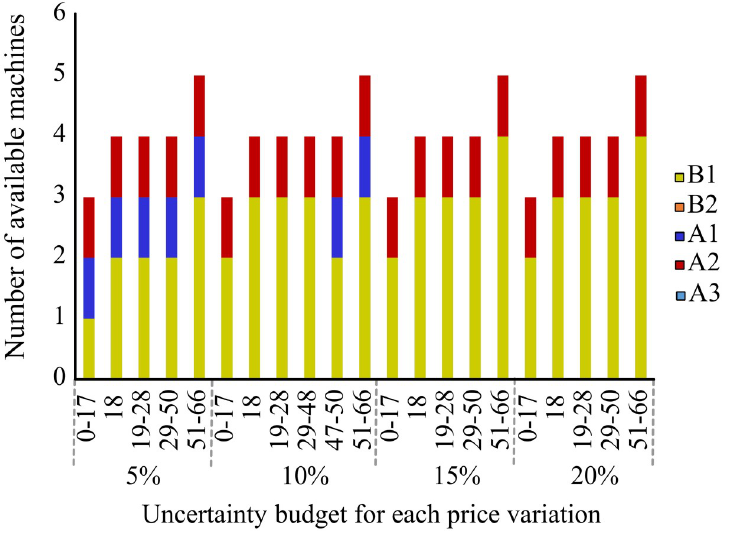
Fig 10. Machinery configuration for variation on A1 price from